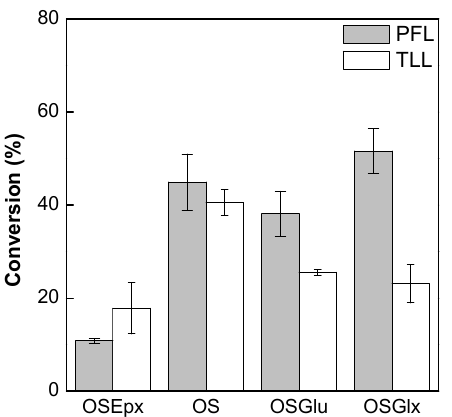
Figure 3. Synthesis of fructose oleate at 35 °C for 12 h of reaction using molar ratio fructose/oleic acid of 1:5 in tert ‐ butyl alcohol medium (0.51 IU/mL of solvent) without the addition of water.